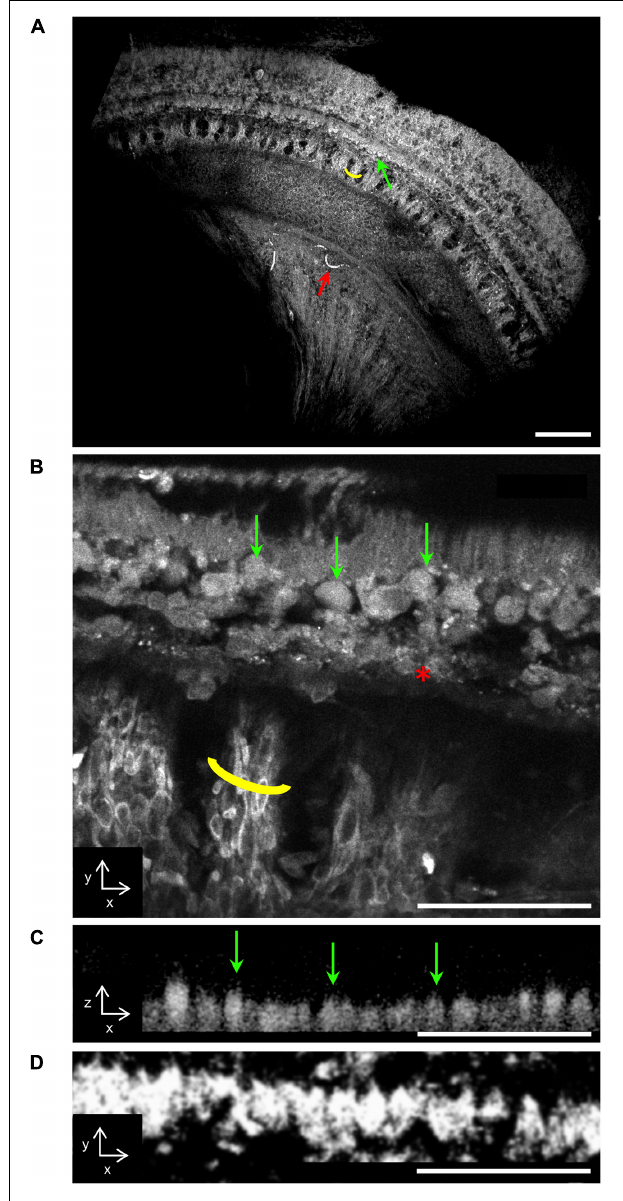
FIGURE 1 | (A) Two-photon fluorescence microscopy (TPFM) of the unstained, in situ organ of Corti. Low magnification (16 × ) view of the basal turn of the organ of Corti. The green arrow indicates the row of inner hair cells, the yellow outline indicates auditory nerve fiber bundles, and the red arrow indicates vasculature. (B) TPFM high magnification (25 × ) view of the region depicted in panel (A) , revealing auditory nerve fiber bundles (yellow outline) and individual sensory (green arrows) and supporting cells (asterisk). (C) High magnification (25 × ) view of the organ of Corti’s inner hair cell (IHC) region in cross-section, revealing individual IHCs (green arrows). (D) Maximum projection confocal image of the organ of Corti stained with myosin VI and VIIa at the row of inner hair cells shows a similar appearance to panel C. Scale bars: 100 µ m in panel (A) , 50 µ m in panels (B–D) ,